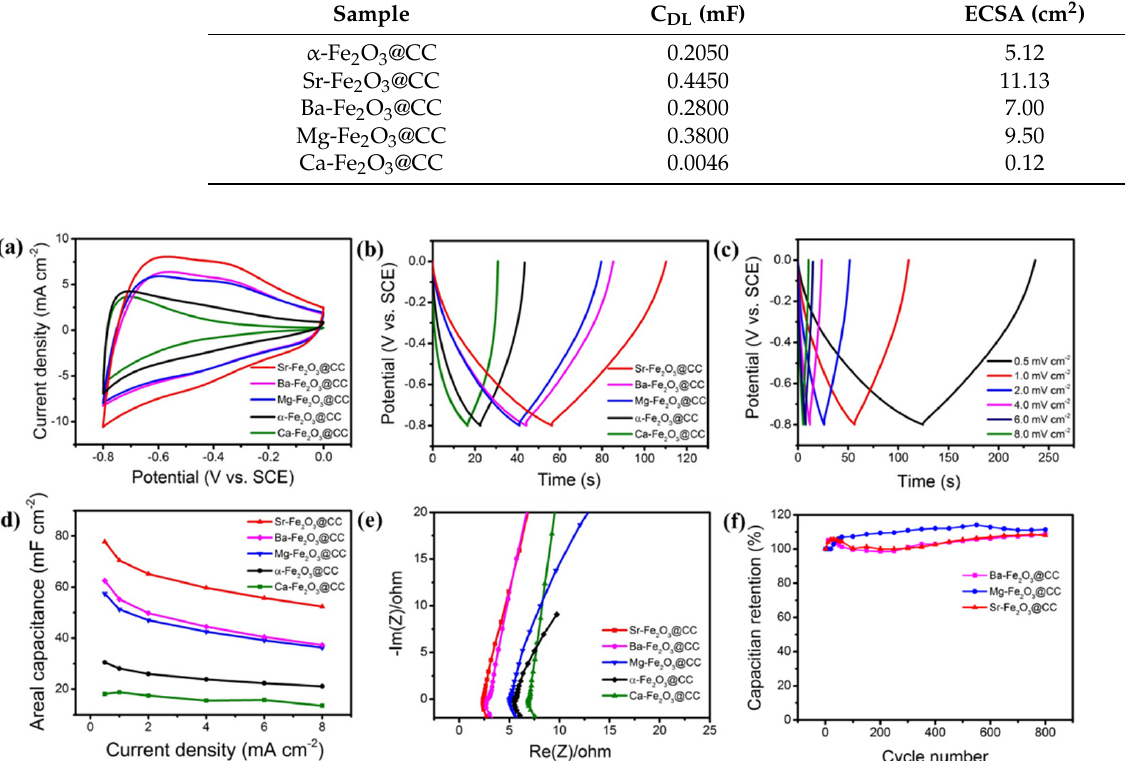
Figure 5. ( a ) CV curves collected at a scan rate of 100 mV s − 1 for Sr-Fe 2 O 3 @CC, Ba-Fe 2 O 3 @CC, Mg-Fe 2 O 3 @CC, α -Fe 2 O 3 @CC, and Ca-Fe 2 O 3 @CC. ( b ) GCD curves collected at a current density of 1 mA cm − 2 for Sr-Fe 2 O 3 @CC, Ba-Fe 2 O 3 @CC, Mg-Fe 2 O 3 @CC, and Ca-Fe 2 O 3 @CC. ( c ) GCD curves for the Sr-Fe 2 O 3 @CC electrode collected at different current densities. ( d ) Specific areal capacitances and ( e ) EIS curves for Sr-Fe 2 O 3 @CC, Ba-Fe 2 O 3 @CC, Mg-Fe 2 O 3 @CC, and Ca-Fe 2 O 3 @CC at different current densities. ( f ) Cycling stability for Ba-Fe 2 O 3 @CC, Mg-Fe 2 O 3 @CC, and Sr-Fe 2 O 3 @CC at a current density of 1 mA cm − 2